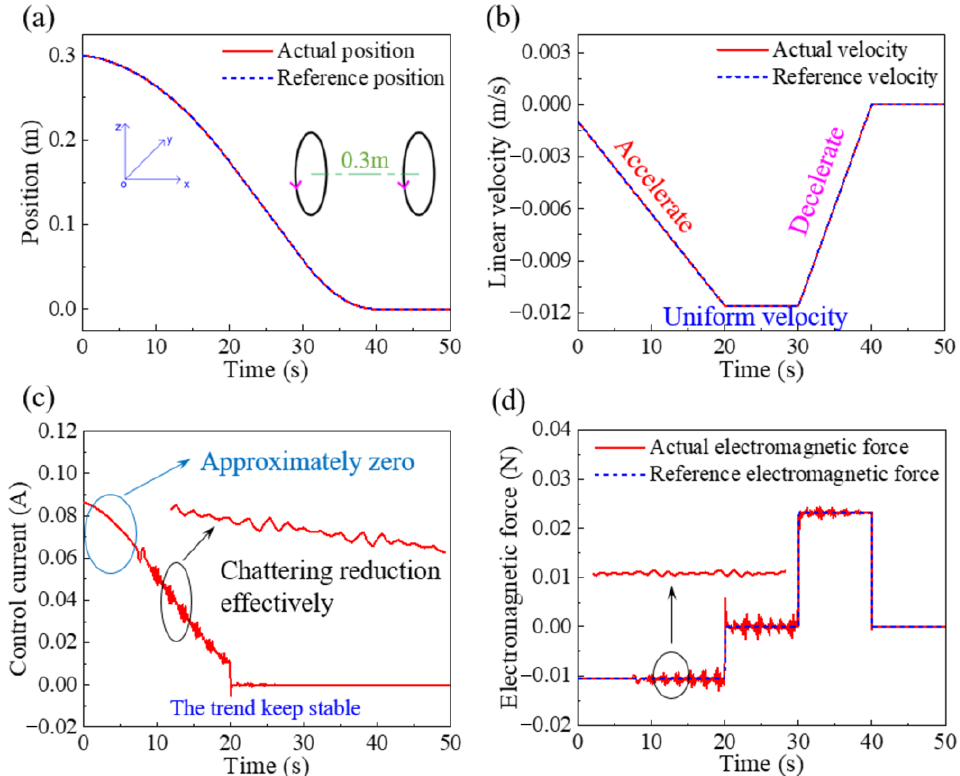
Figure 11. The position ( a ), linear velocity ( b ), control current ( c ), and electromagnetic force ( d ) of the sliding mode control based on the quasi sliding mode with the non-interfering condition.